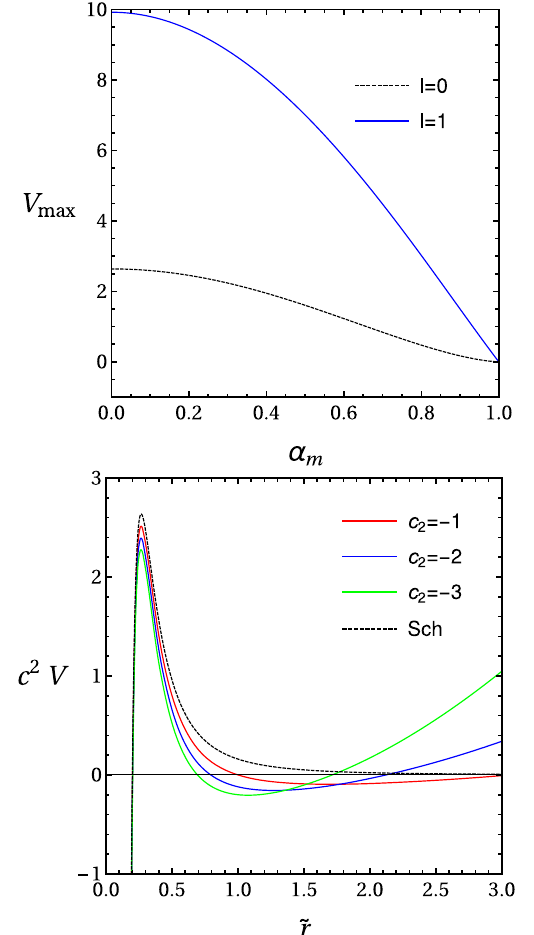
Fig. 3 TheleftpanelshowsthemaximumpotentialforadeSitterblack hole versus the model parameter α m with (cid:18) = 0 ,(cid:18) = 1, ˜ M = α g = 0 . 1. The right panel shows the potential for a de Sitter black hole with different values of c 2 compared to the Schwarzschild case; black-dotted line for the Schwarzschild case, red line for c 2 = − 1, blue line for c 2 = − 2 and green line for c 2 = − 3